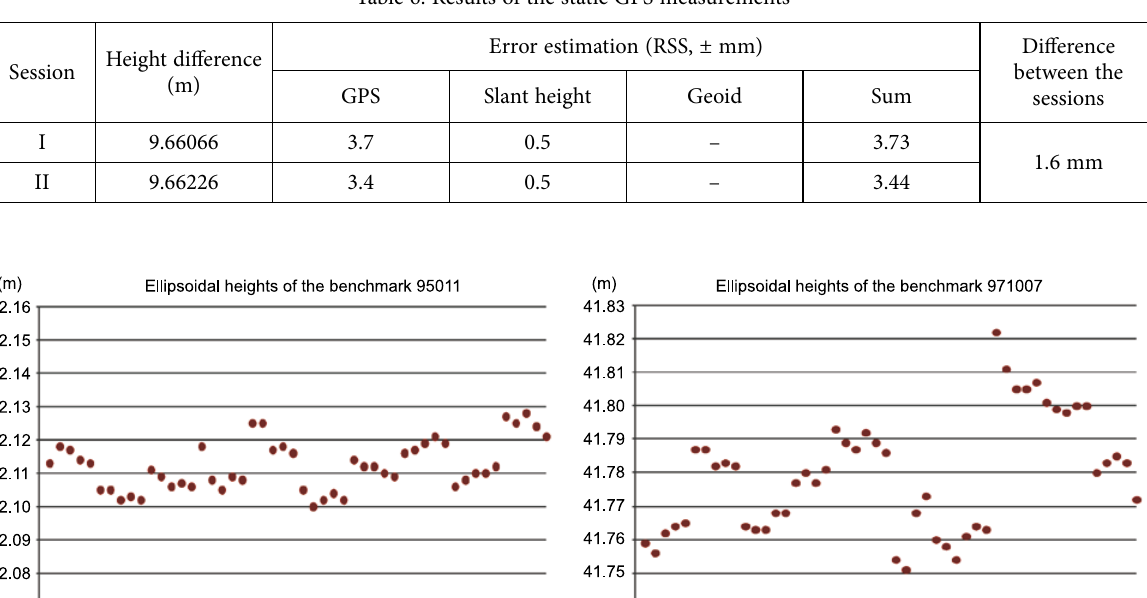
Table 6. Results of the static GPS measurements